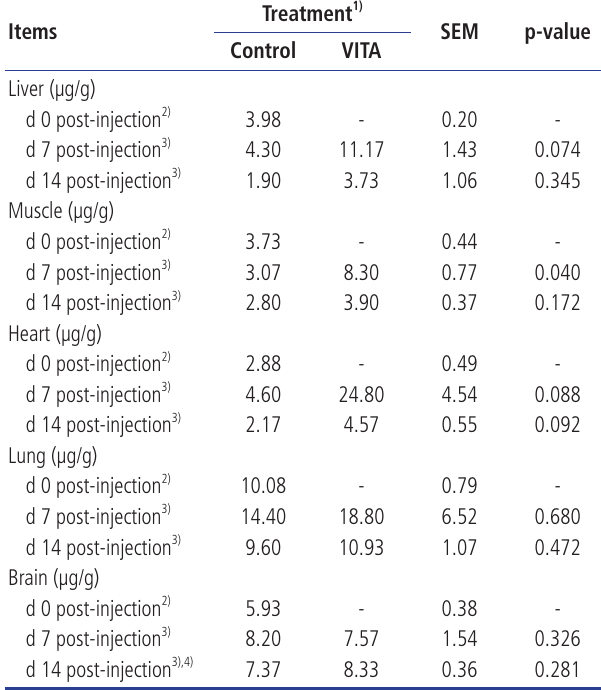
Table 5. Alpha-tocopherol concentrations in liver, muscle, heart, lung and brain of pigs administered with fat-soluble vitamins